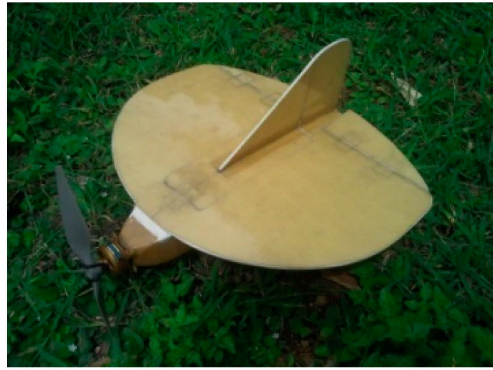
Figure 2. Black Kite micro aerial